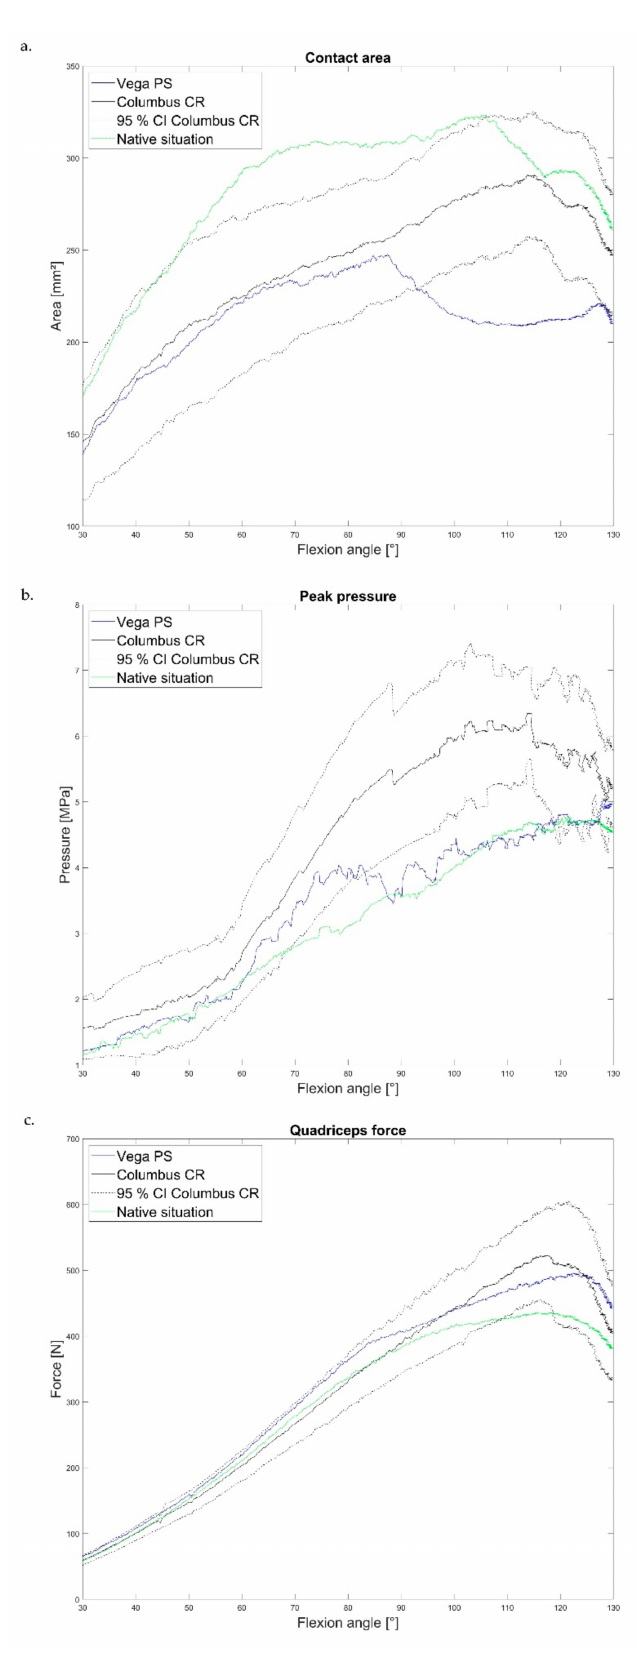
Figure 2. Mean values of all specimens ( n = 8) for ( a ) retropatellar contact area, ( b ) retropatellar peak pressure, ( c ) quadriceps force of Vega PS (blue), Columbus CR (black), 95% CI of Columbus CR (black dashed), and native situation